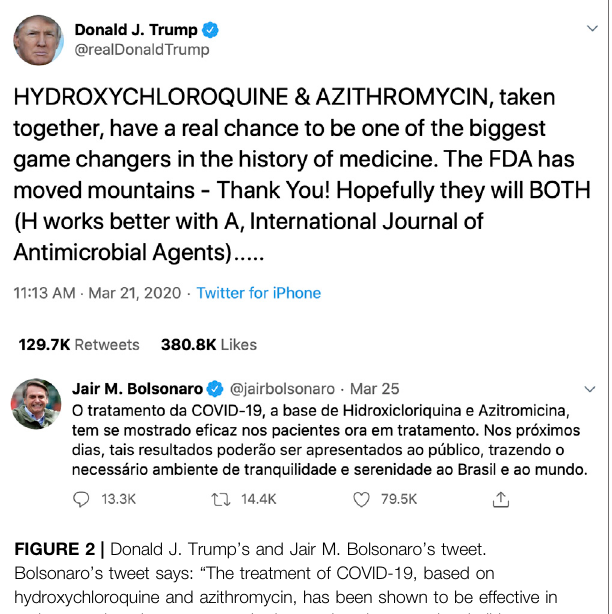
FIGURE 2 | Donald J. Trump ’ s and Jair M. Bolsonaro ’ s tweet. Bolsonaro ’ s tweet says: “ The treatment of COVID-19, based on hydroxychloroquine and azithromycin, has been shown to be effective in patients undergoing treatment. In the coming days, results shall be presented to the public, bringing the necessary atmosphere of tranquility and serenity to Brazil and the world. ”